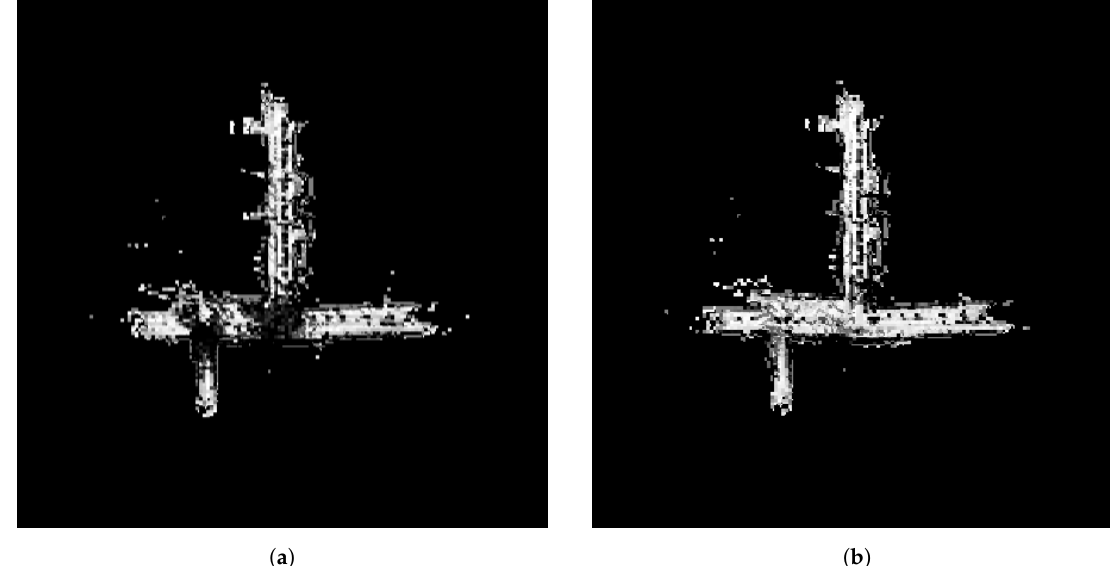
Figure 6. A comparison of the output of the traversability labelling pipeline with the ( a ) naïve registration approach and the ( b ) segmentation based approach as described in Section